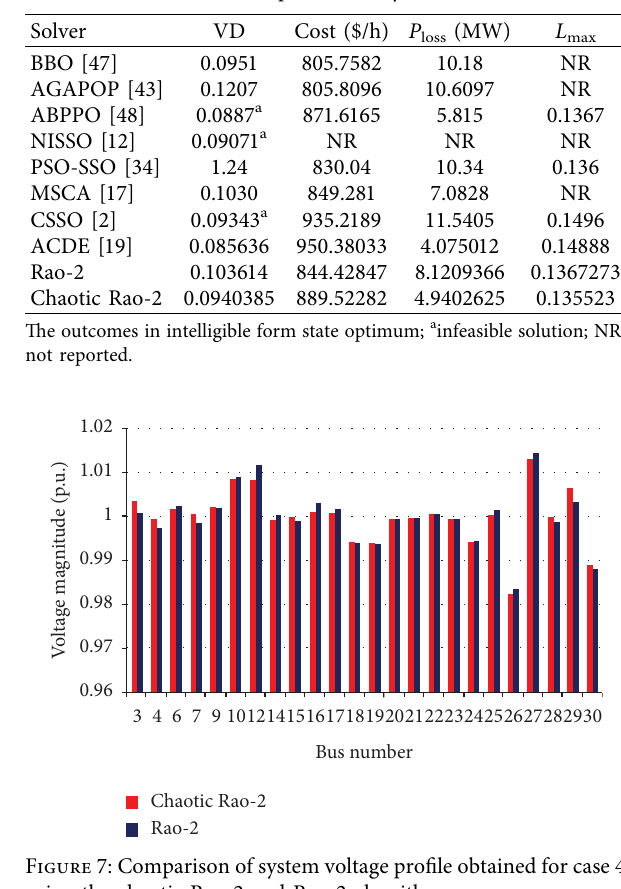
Figure 6: Convergence traits for case 4 using Rao-2 and the chaotic Rao-2 algorithms. Table 6: Comparison study for case 4.